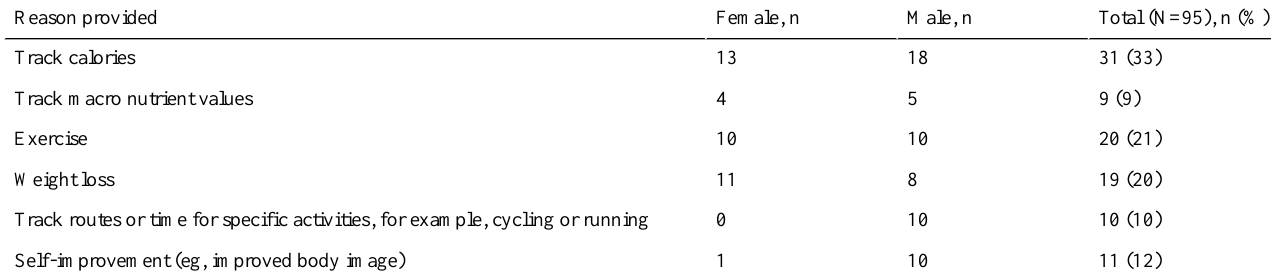
Table 1. Reported motivation to engage with healthy eating and fitness